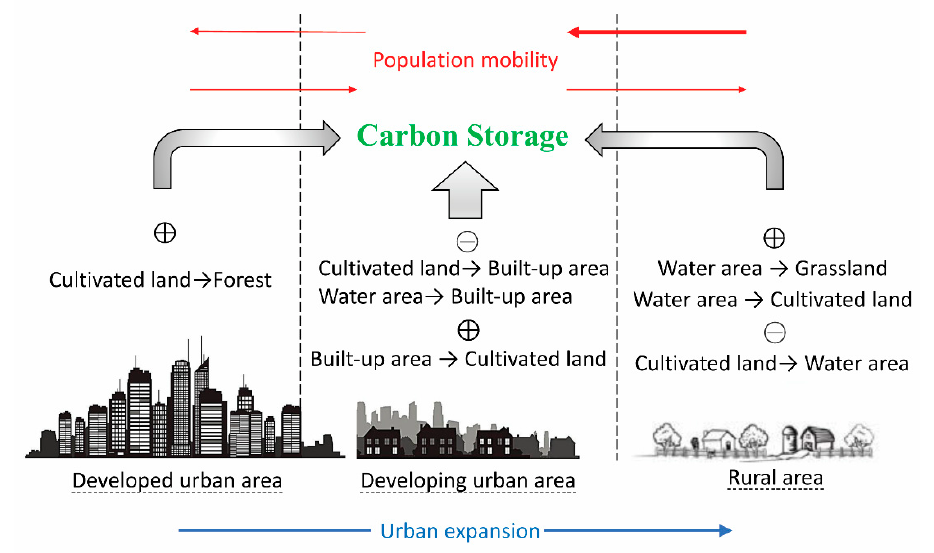
Figure 8. Conceptual diagram of the impacts of urbanization-induced land-use change on carbon storage (“ + ” and “ − ” represent the positive and negative impacts of land-use change on carbon storage. The red and blue arrows represent population mobility and urban expansion, respectively).